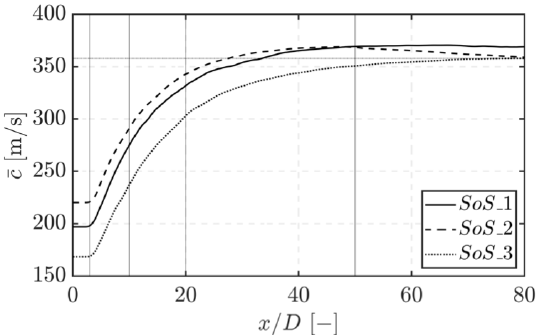
Figure 10. Time-averaged mixture speed of sound along the center line. The horizontal line at c ≈ 355m/s corresponds to the speed of sound of pure nitrogen.